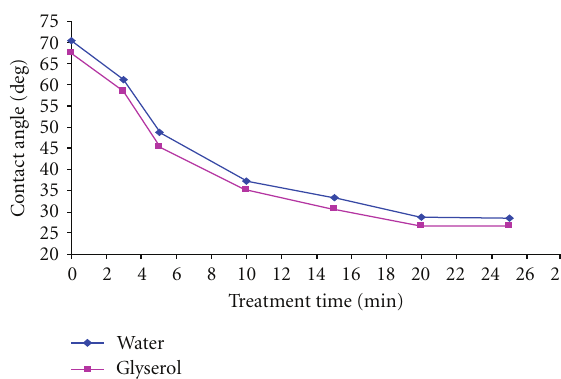
Figure 2: Variation of contact angle with respect to treatment